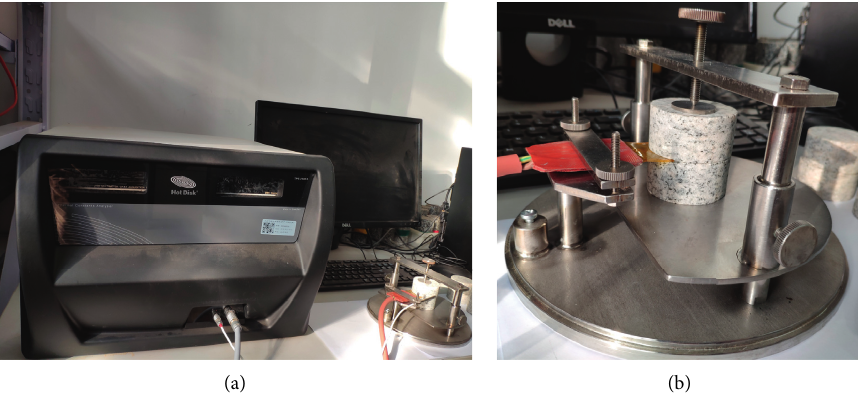
Figure 1: Physical drawing of the thermal constant analyzer.